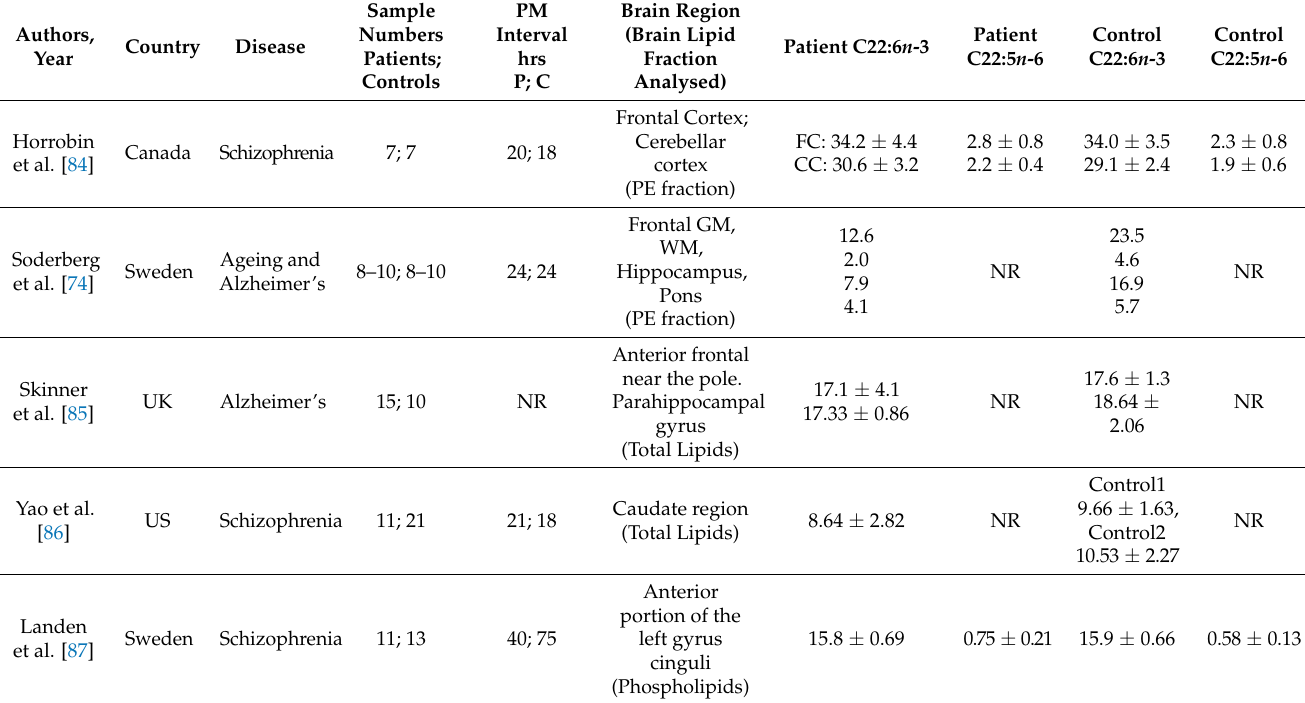
Table A1. DHA and C22:5n-6 proportion in post-mortem brain samples (% of total fatty